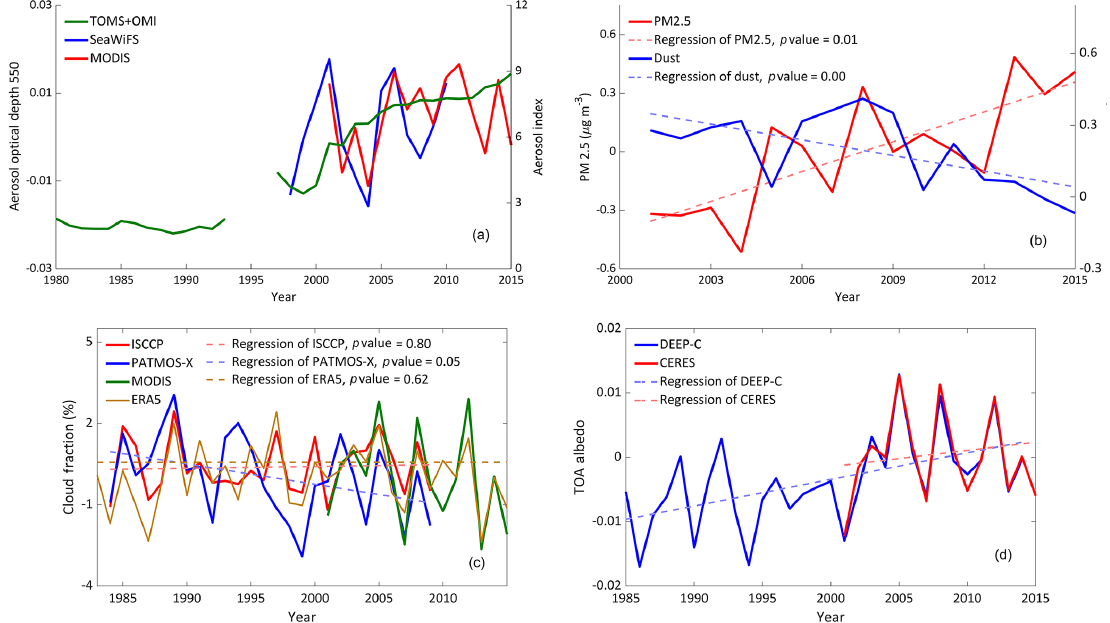
Figure 5. Temporal variation in detected factors from remote sensing products over the TP: (a) AOD and aerosol index, (b) PM 2 . 5 and dust, (c) cloud fraction, and (d) TOA